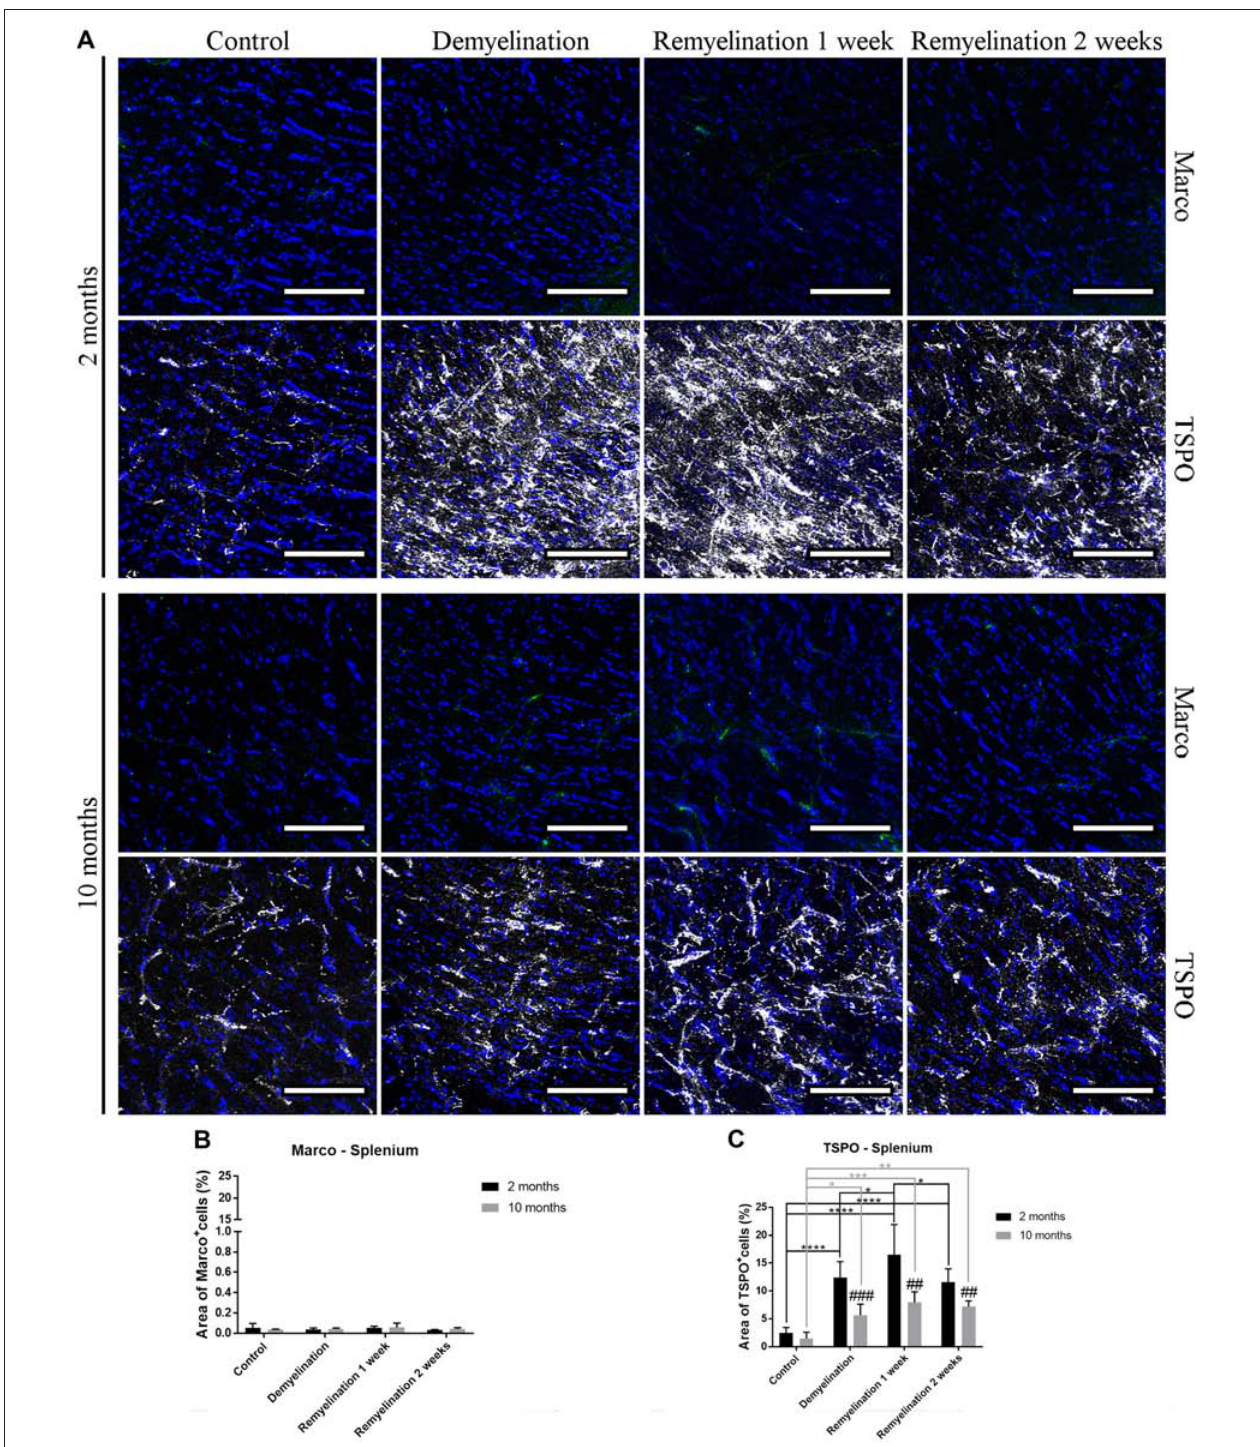
FIGURE 8 | Age-related differences in cuprizone-induced increase of TSPO in the splenium of the CC, while Marco remains unaffected. (A) Marco (green) and TSPO (white) labeling. Cell nuclei are stained with DAPI (blue). (B) No significant effects of age or treatment on Marco levels were observed. (C) In both age groups, TSPO was significantly increased during de- and remyelination. TSPO levels were significantly higher in the younger de- and remyelination groups. Values are shown as means + SD ( n = 6 per group). Statistical significance was evaluated using a two-way ANOVA followed by a Tukey’s post hoc test (C) . The p -values are indicated in the graphs: treatment effects within the same age group: ∗ p < 0.05, ∗∗ p < 0.01, ∗∗∗ p < 0.001 and ∗∗∗∗ p < 0.0001, age-related differences: ## p < 0.01 and ### p < 0.001. Bars: (A) 100 µ m.